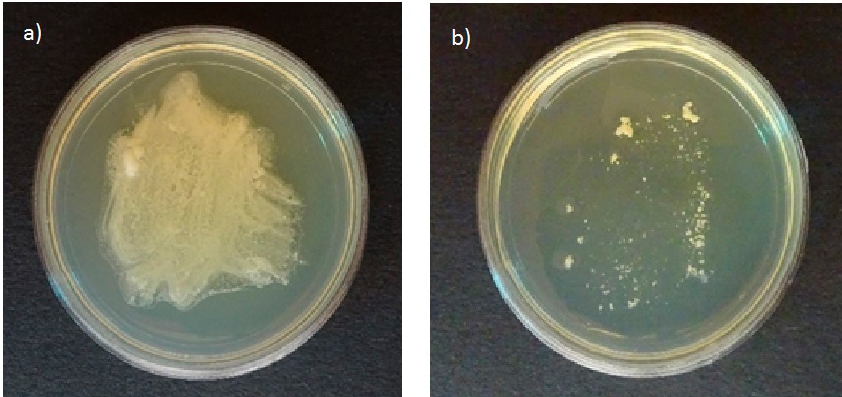
Figure 1. Growth profiles of Malassezia furfur on agar plates selective for pathogenic fungi in ( a ) the presence and ( b ) the absence of nutritional substances.